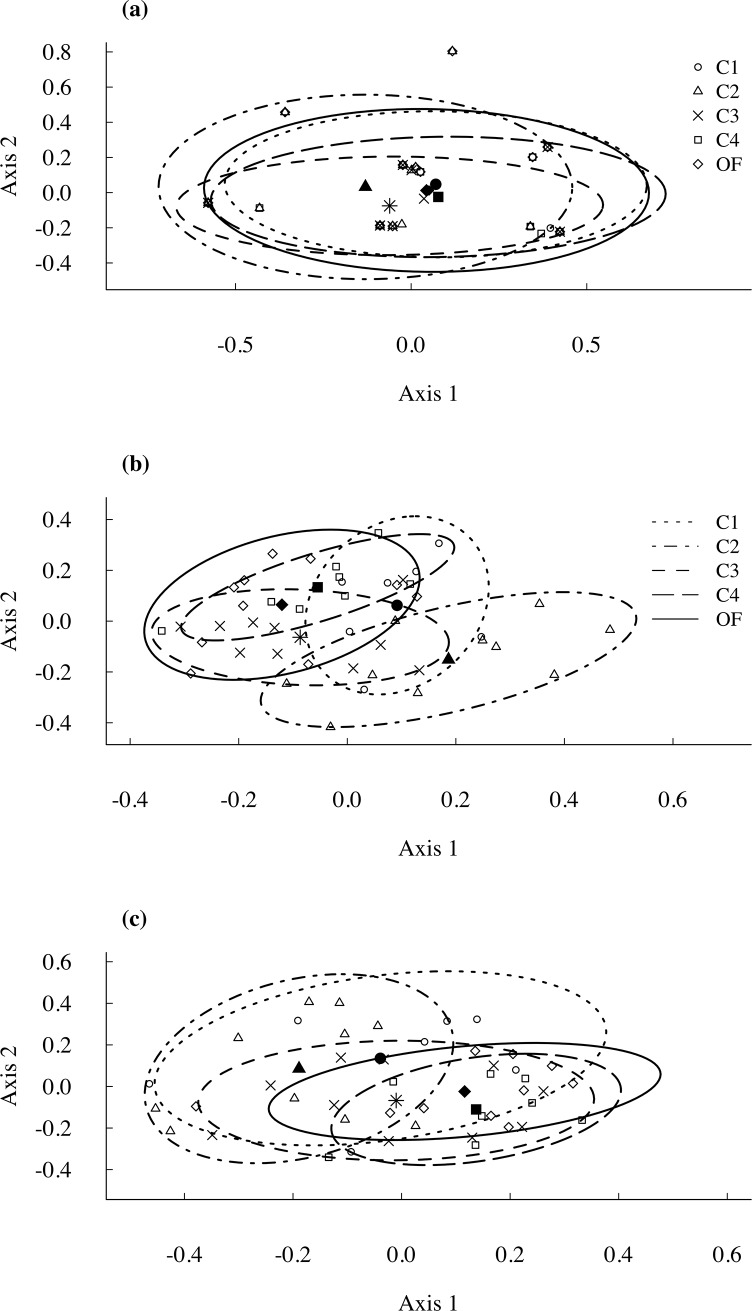
Ordination plots represent dissimilarity in assemblage patterns.Ordination plots of the principal coordinates analyses (based on dissimilarity matrices calculated from Sorensen indices) representing dissimilarity in assemblage patterns among boreal forest age classes for a) small mammals, b) ground-dwelling beetles, and c) flying beetles. The ellipses enclose 80% of the variability in compositional differences accounted for by the first two axes. We used solid lines for old-growth forest, and dashed lines for cut stands of different age after clear-cutting. Age classes: C-1, C-2, C-3, and C-4: 4–20, 21–30, 31–50, and 51–70-years-old clear-cut stands, respectively, OF is for old-growth forest of at least 120-years-old. The solid symbols represent the centroids of the ellipses for each class (C1: circle, C2: triangle, C3: star, C4: square, C5: diamond).